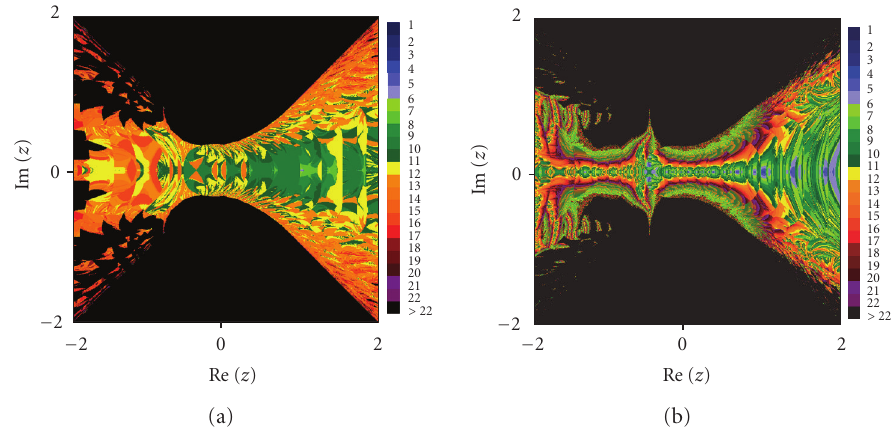
Figure 4.2. Basins of attraction for z 3 − 1 = 0 using (4.6). (a) PR method and W-L.S. (b) FR method and W-L.S.